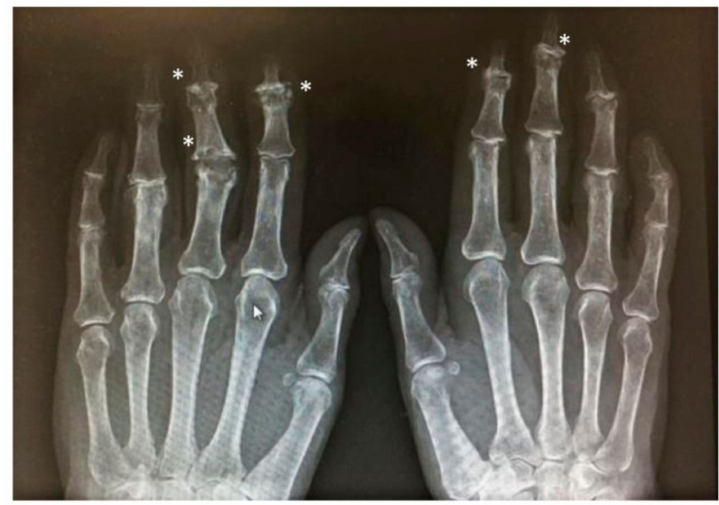
Figure 2. X-rays of hand show radiologic features of interphalangeal involvement in PsA (asterisk). “Saw tooth” appearance is another characteristic configuration of EHOA, found especially in PIP [1] (Figure